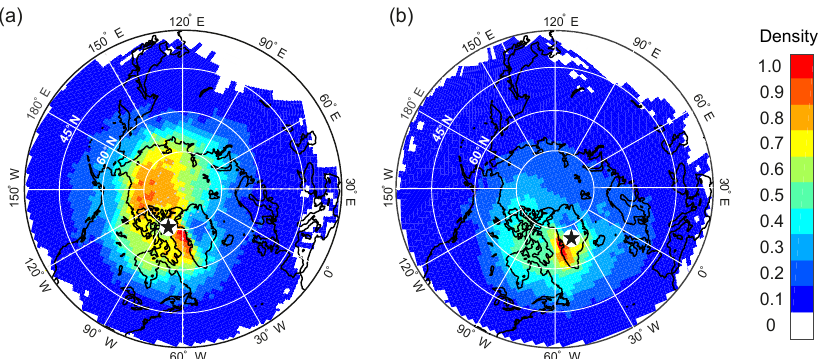
Figure 8. Maps of residence time probability for air arriving at (a) Devon ice cap and (b) Summit, Greenland over the period from 1948 to 1999, computed using HYSPLIT4. Air residence probability densities were normalized to a scale of 0–1, and were spatially detrended by multiplying the original residence time grids (in hours) by the distance between each grid point and the coring site. This effectively removes the concentric increase in probability density near the back-trajectory start point (Ashbaugh et al., 1985). The spatial resolution of the grid is 200 ×